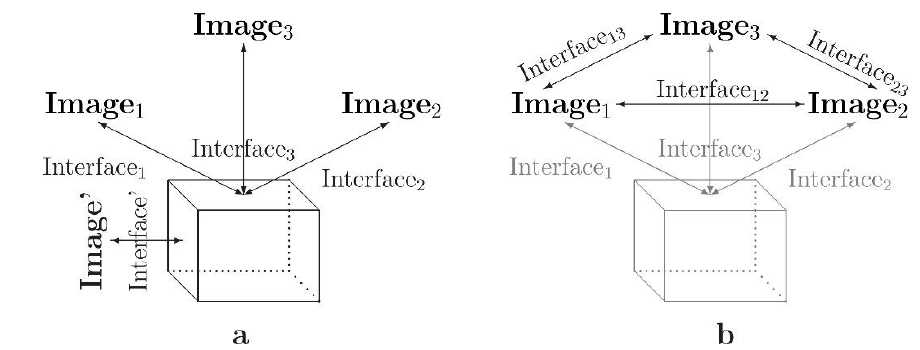
Fig. 4. (a, b) Illustration to the model-triad definition.